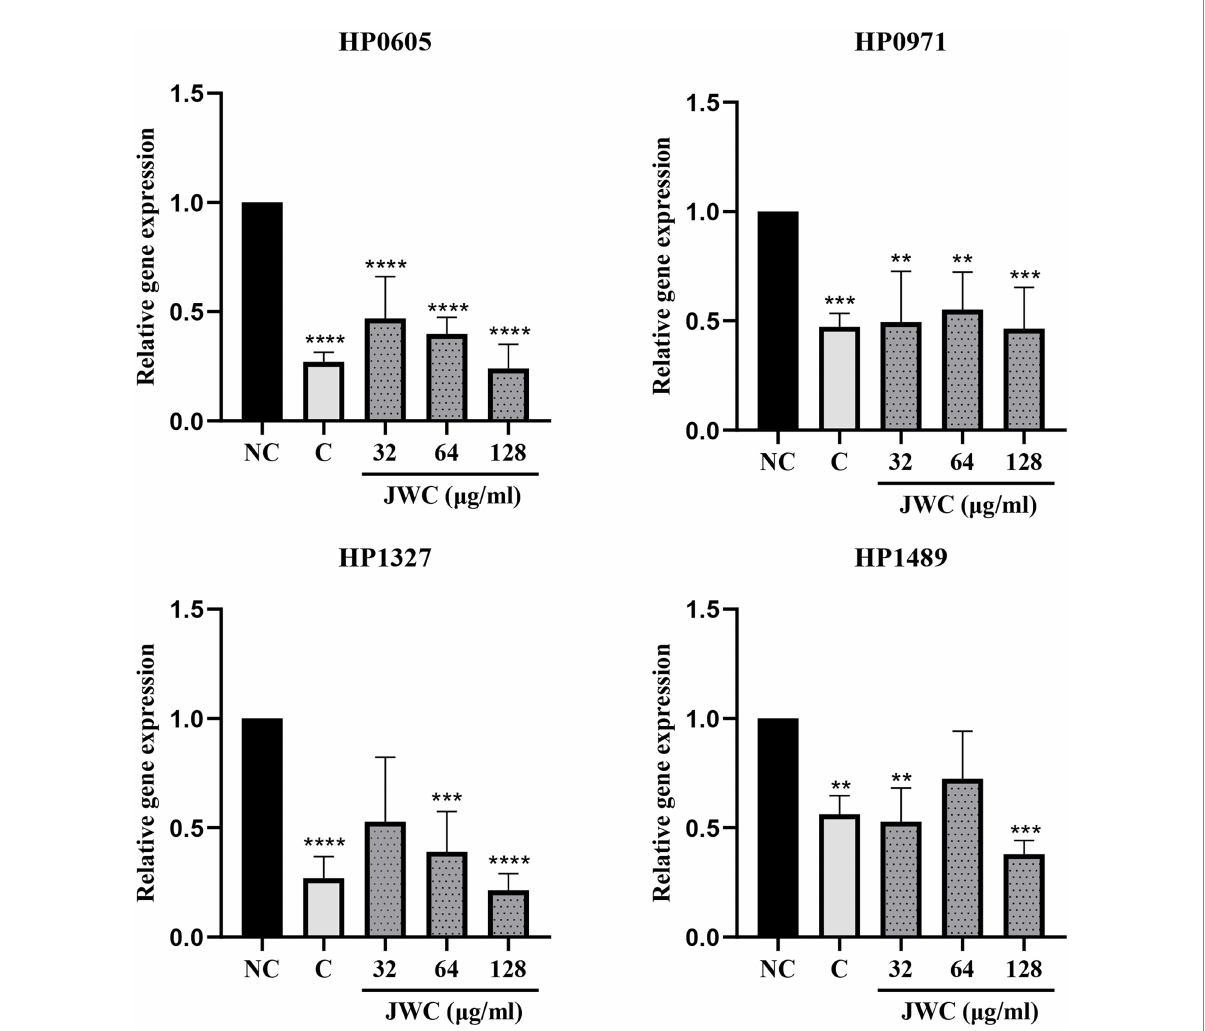
FIGURE 6 Expression of different efflux effect genes of H. pylori 26,695–16R after incubation with Pa β N, CCCP and different concentrations of JWC. NC, Normal control group; C, CCCP (1 μ g/ml); ** p < 0.01, *** p < 0.001, **** p < 0.0001, compared with the results of the control